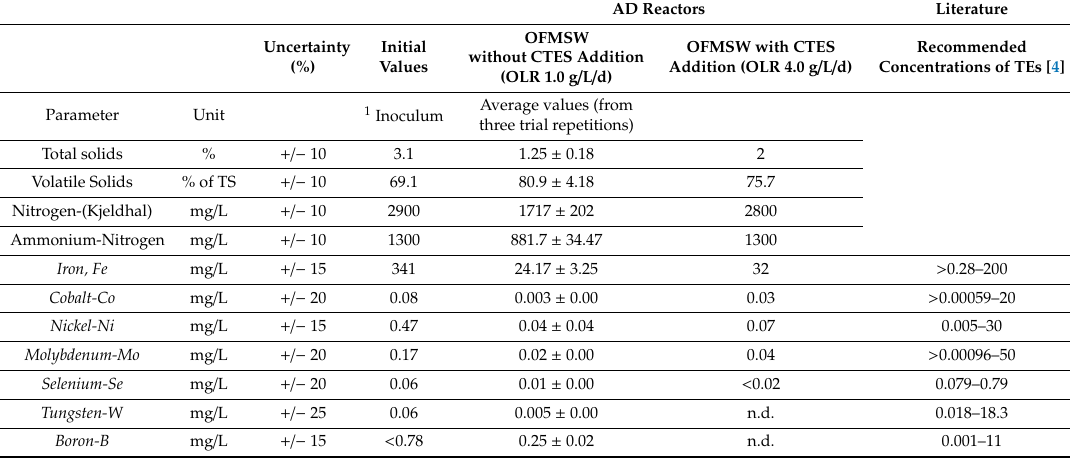
Table 3. Nutrients and trace elements in the reactors fed with OFMSW. A comparison between recommended Trace Elements (TE) concentration in the literature and the TE concentrations in the Anaerobic Digestion (AD)